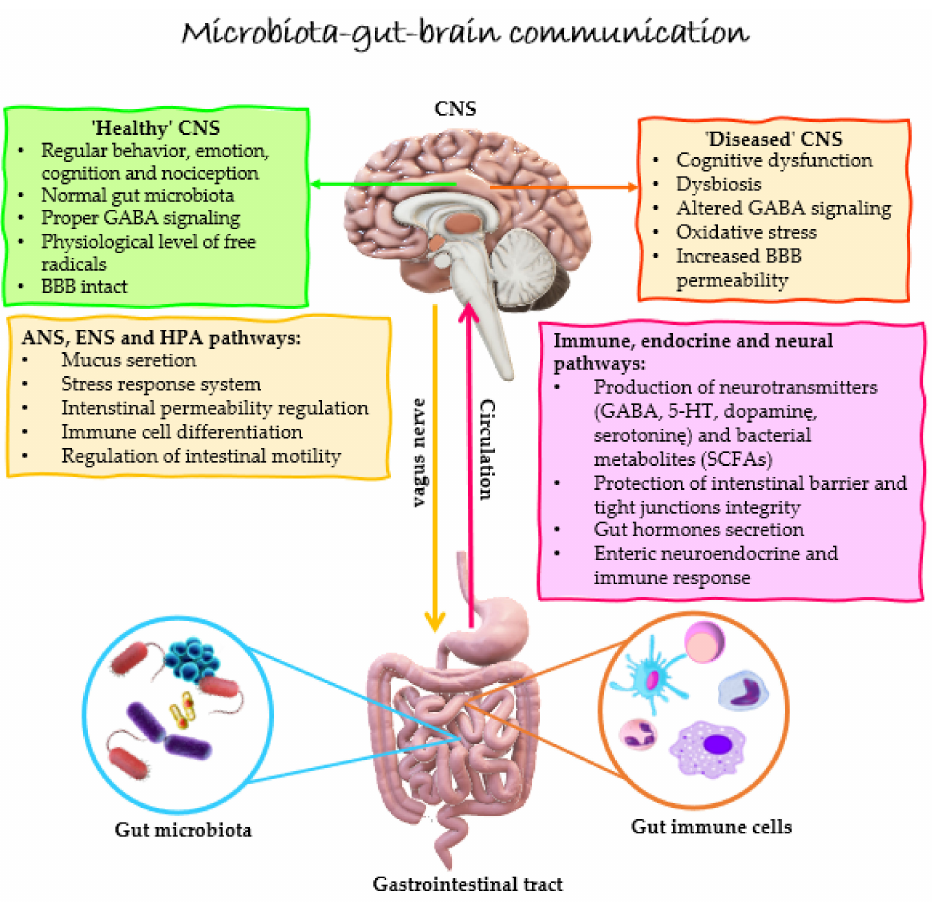
Figure 1. Schematic diagram showing the microbiota-gut-brain communication. Bidirectional in- teraction between the gut microbiota and the CNS is mediated by a few pathways of the GBA, including ANS, ENS, HPA, and the immune, neuroendocrine, as well as neural pathways. Within the intestines, the gut microbiota can produce neuroactive compounds, such as neurotransmitters (e.g., GABA, dopamine, and 5-HT) and microbial-derived metabolites (e.g., SCFAs). Altered gut microbiota (dysbiosis) may impair CNS activity, which is manifested by declined cognitive function, altered GABA signaling, enhanced free radicals level, and increased barriers permeability (BBB and gut barrier). Abbreviations: 5-HT—serotonin; ANS—autonomic nervous system; BBB—blood-brain barrier; CNS—central nervous system; ENS—enteric nervous system; GABA—gamma-aminobutyric acid; GBA—gut-brain axis; HPA—hypothalamic–pituitary–adrenal; SCFAs—short-chain fatty